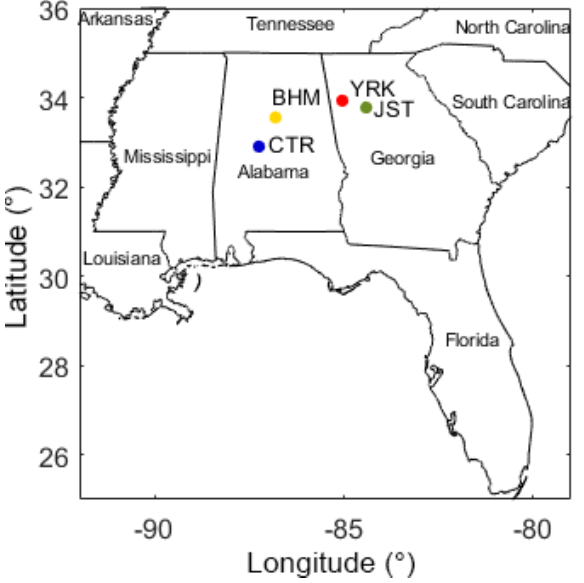
Figure 1. Map of the SEARCH network showing urban and rural sites: YRK is Yorkville, GA (rural); JST is Jefferson St., Atlanta, GA (urban); CTR is Centreville, AL (rural); BHM is Birmingham, AL (urban). The map was generated using the borders function cre- ated for MATLAB (Greene et al.,